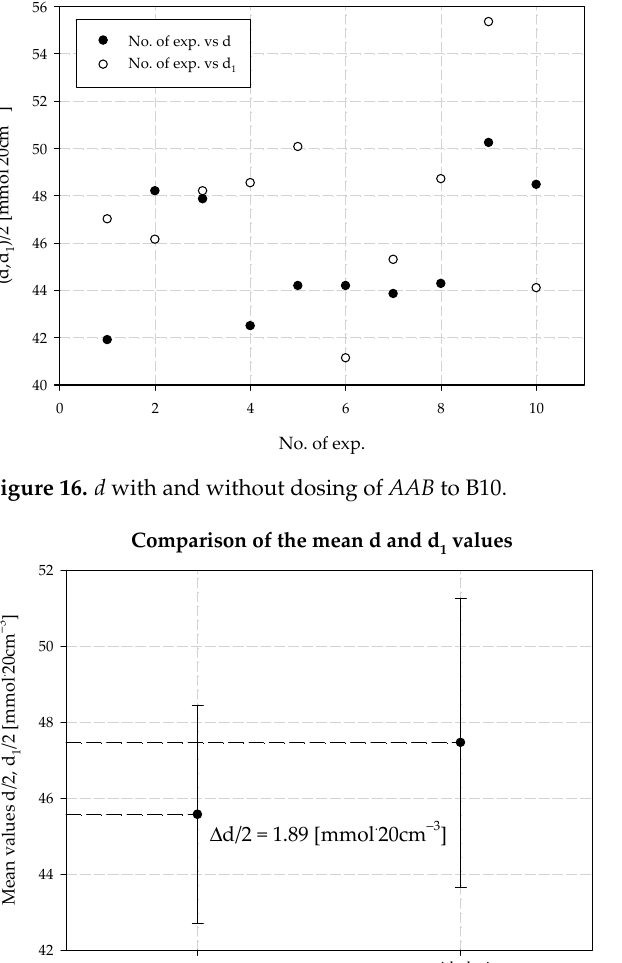
Figure 17. Total carbon dioxide concentration values with and without dosing AAB to B10. CO concentration in off-gas 2